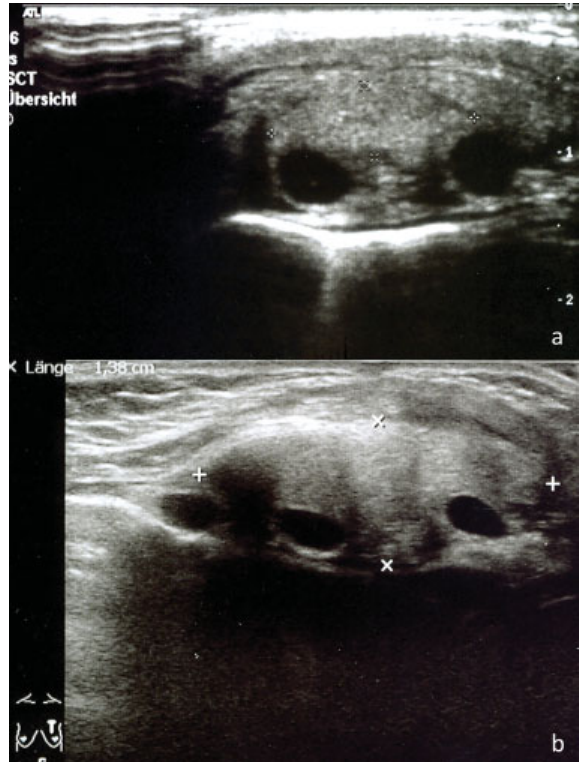
Fig. 1 Progression of the tumor of patient A. (a) Before fi rst surgery. (b) Growing tumor size 5 months after fi rst resection: 4.8 (cid:1) 3.5 (cid:1) 1.4